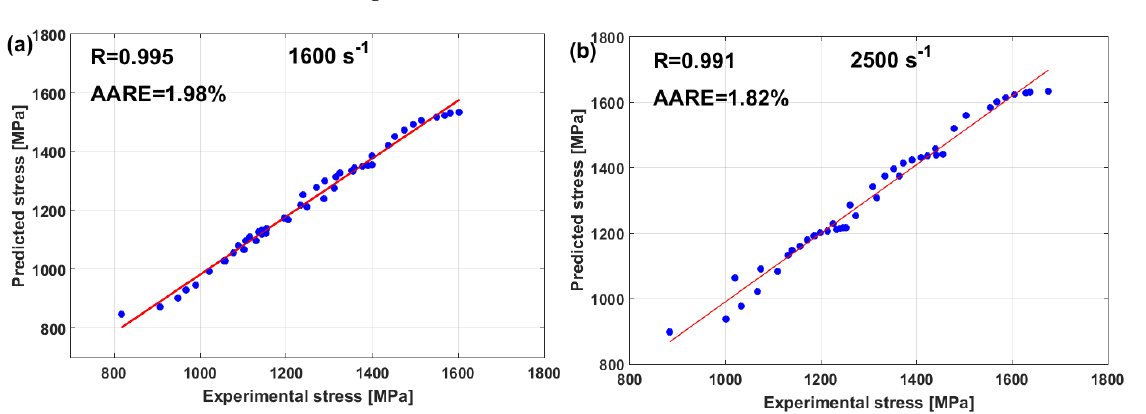
rates, with R = 0.995 and AARE = 1.98% (cf. Figure 18a) and with R = 0.991 and AARE = 1.82% (cf. Figure 18b).